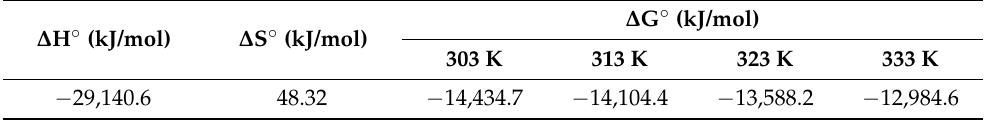
Table 2. Calculated parameters of thermodynamics for RB dye degradation.